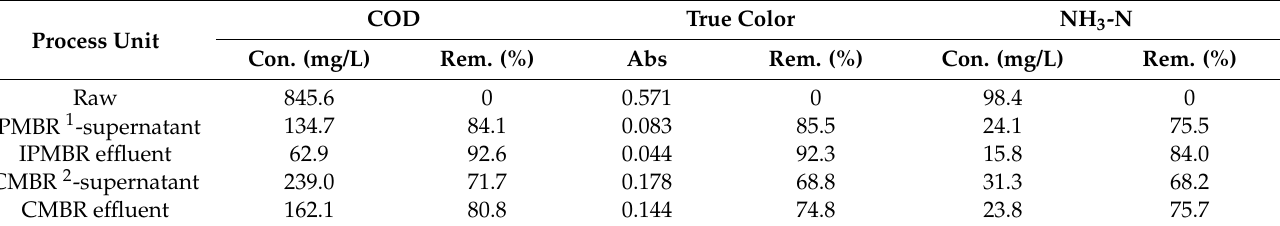
Table 2. COD, true color, and NH 3 -N in the integrated process (average values in concentration).